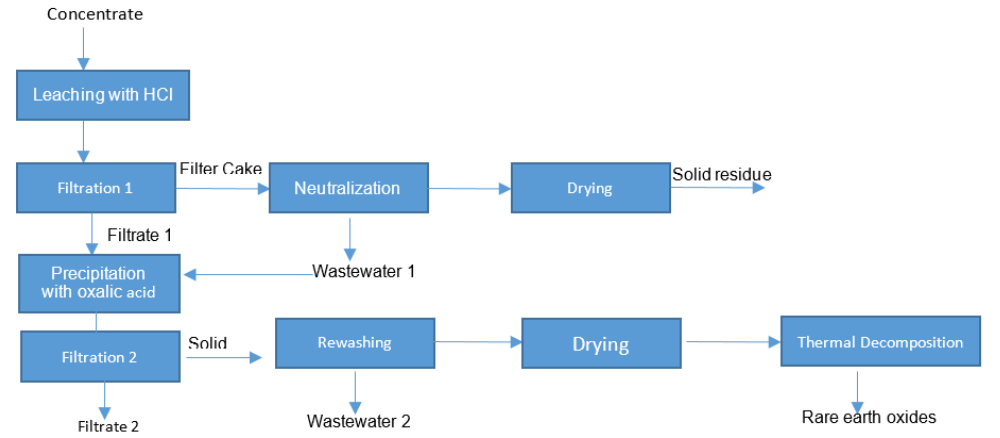
Figure 7. The optimized strategy for the leaching (without thermal conditioning).